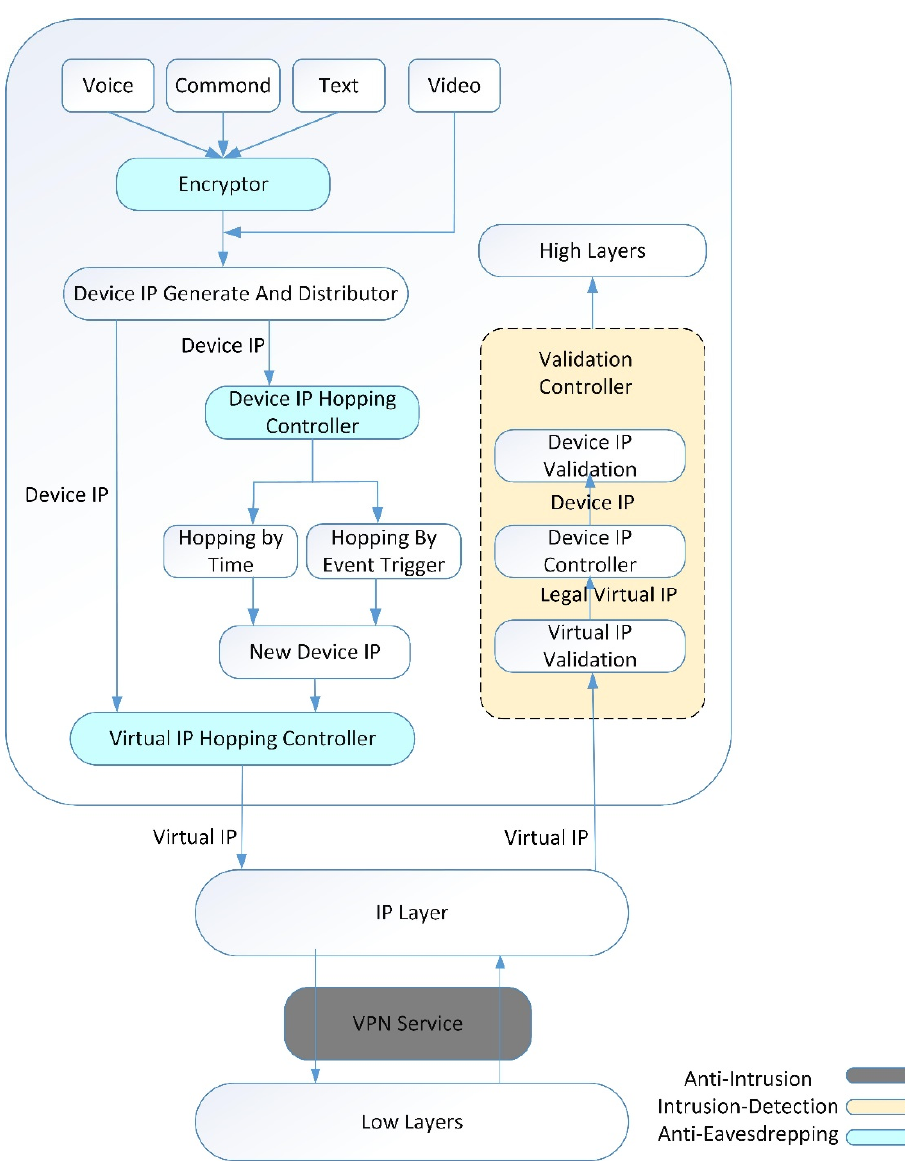
Figure 1. Proposed security scheme embedded two-layer IP hopping.